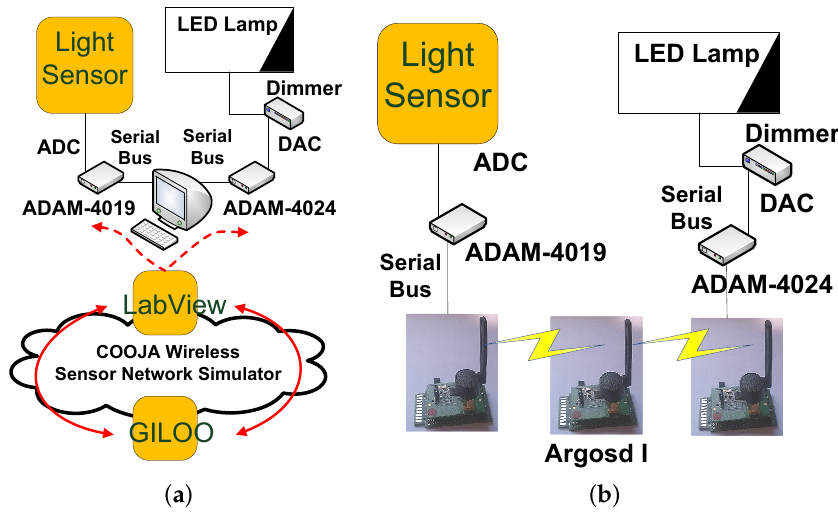
Figure 10. Application architecture: co-simulation and real scenario. ( a ) rapid prototyping architecture; ( b ) real architecture.